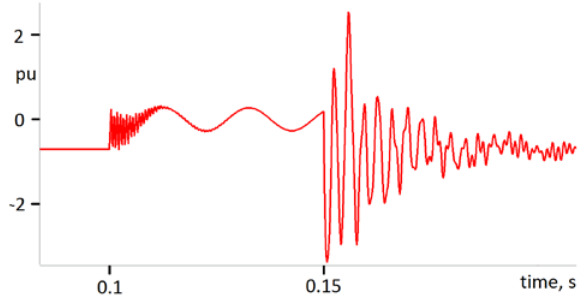
Fig. 9. Course of